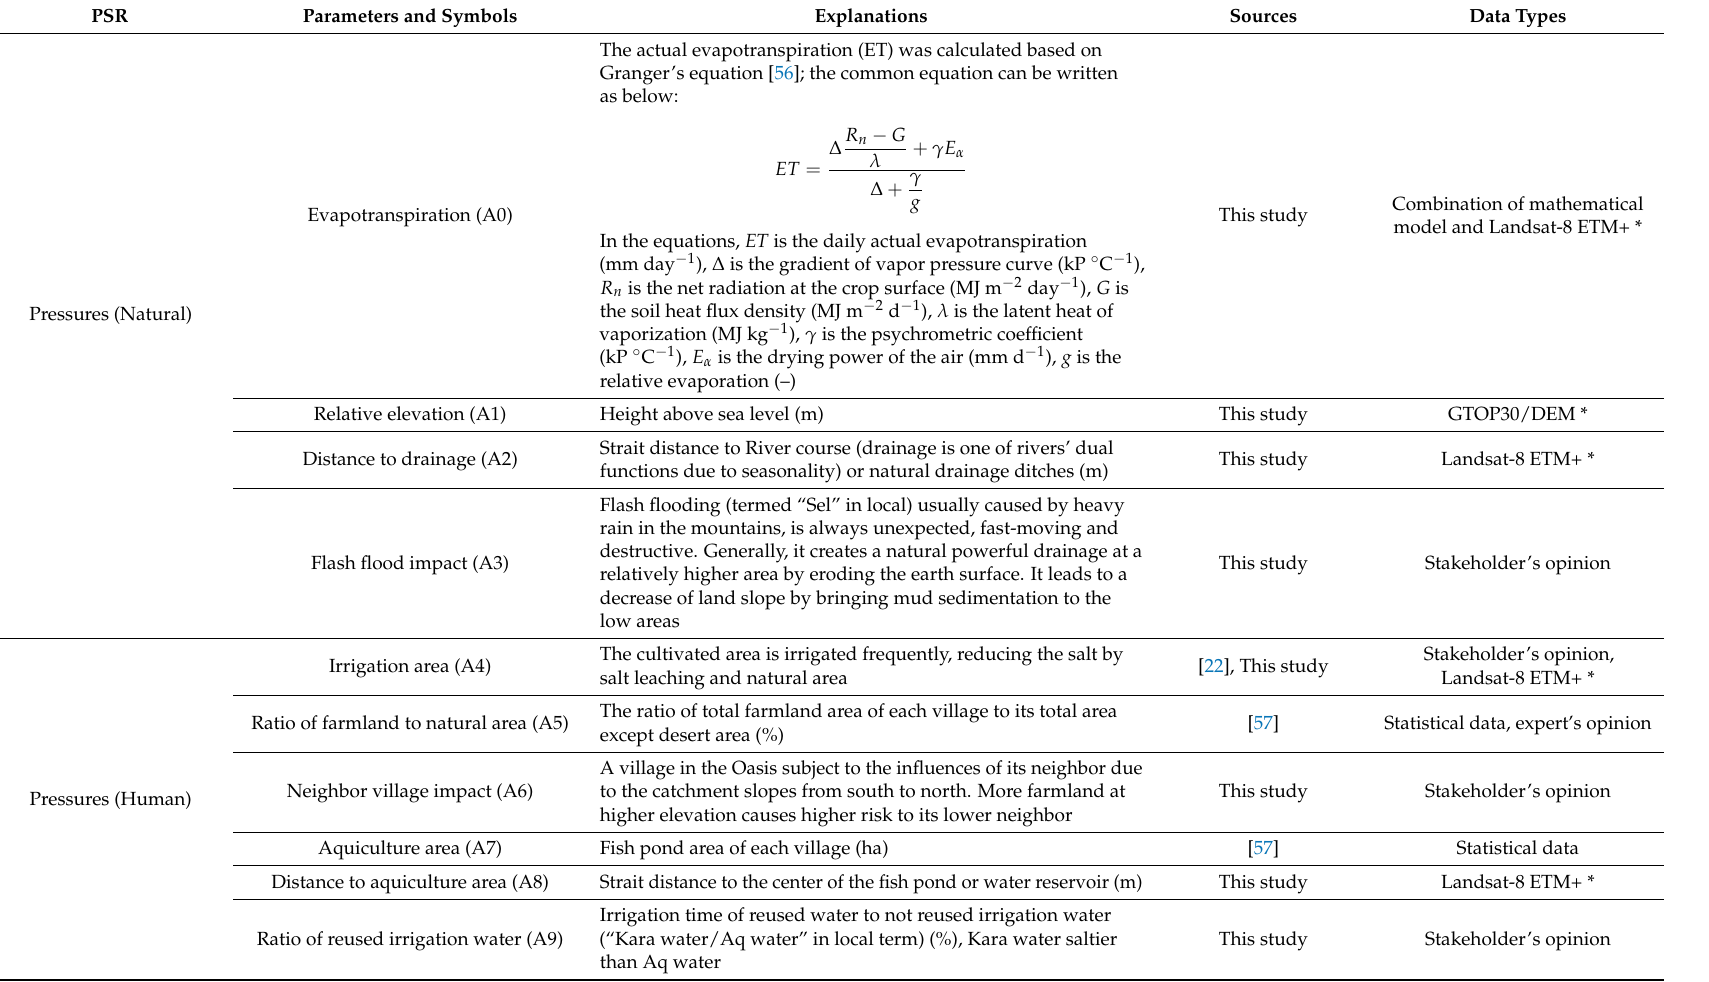
Table 1. Risk parameters within Pressure-State-Response (PSR) categories for irrigation salinity risk assessment and mapping in the Keriya